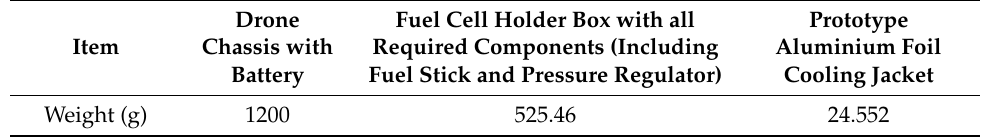
Figure 7. Left: A prototype battery cooling assembly via contact with a solid fuel stick. Right: A view of the prototype cooling assembly mounted on the bottom of the drone. Table 3. Weights of drone